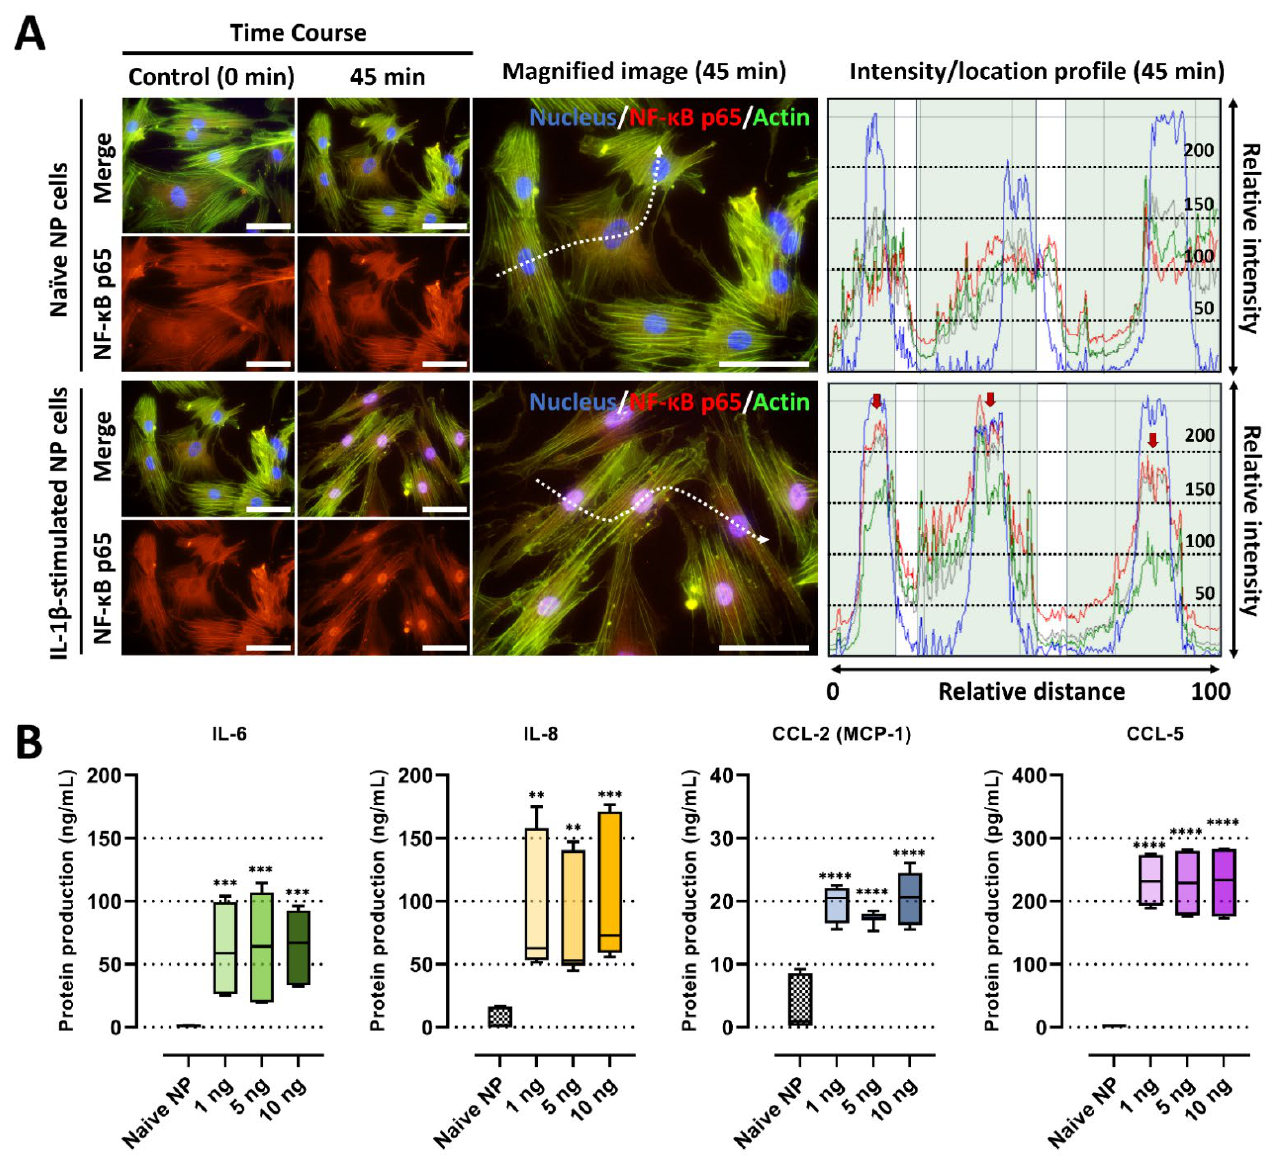
Figure 2. IL- 1β stimulation on human NP cells for degenerative IVD conditions. ( A ) Fluorescence image and quantification of the fluorescence intensity of NF- κB p65 protein in human NP stimulated by recombinant IL- 1β 10 ng/mL. The red arrow indicates the preferential distribution of NF- κB p65 protein in the nucleus. Scale bars, 100 μm. ( B ) The protein production of IL-6, IL-8, CCL-2 and CCL-5 on human NP cells with/without IL- 1β treatment in a dose-dependent manner. The values are reported as the mean ± standard error of four independent experiments. Scale bars, 225 μm. ** p < 0.01, *** p < 0.001, and **** p < 0.0001 as compared with naïve NP cells.